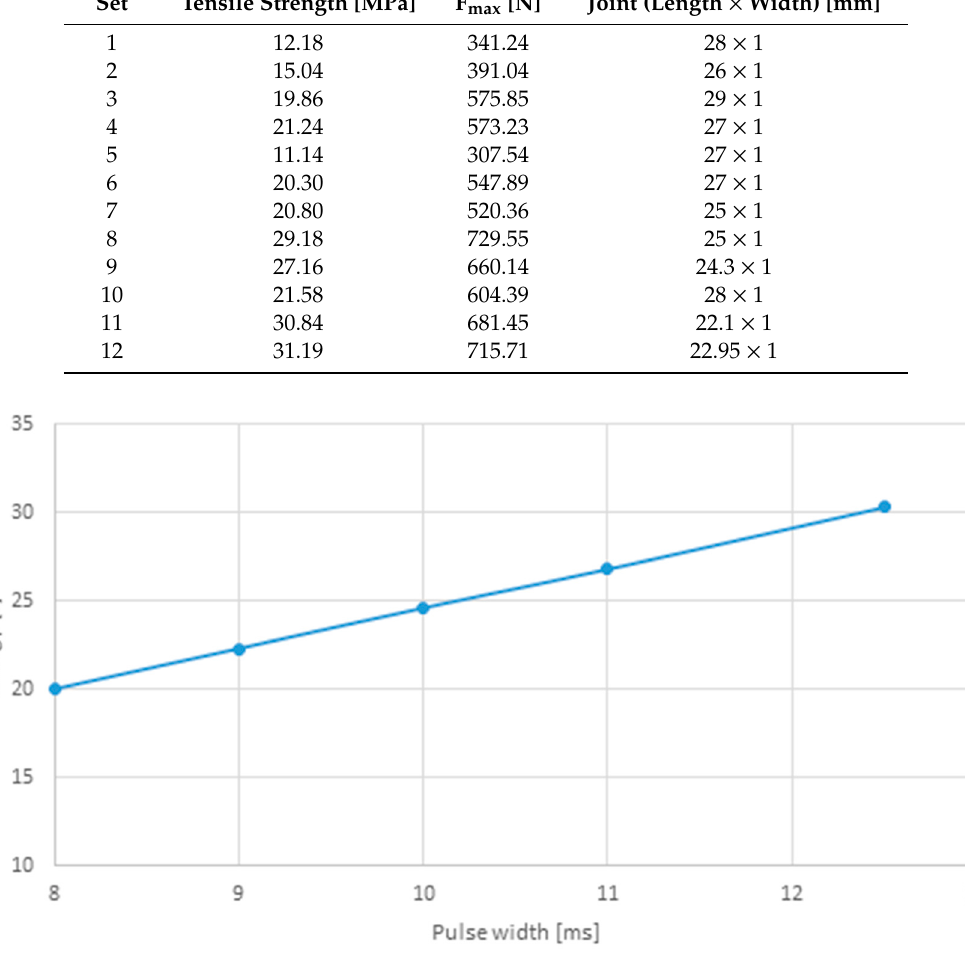
Figure 5. Energy relation with square pulse width (sets 1–5).